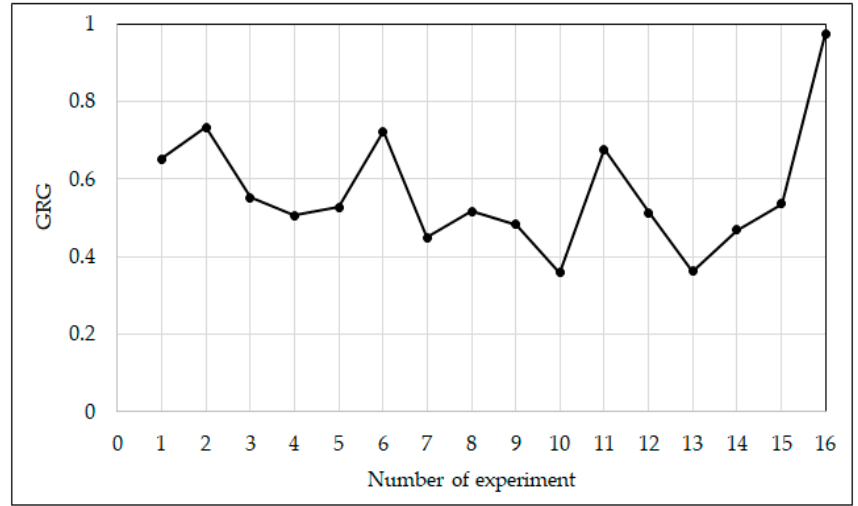
Figure 11. Grade relational grades for response parameters of cutting insert flank wear surface and diameter deviation.